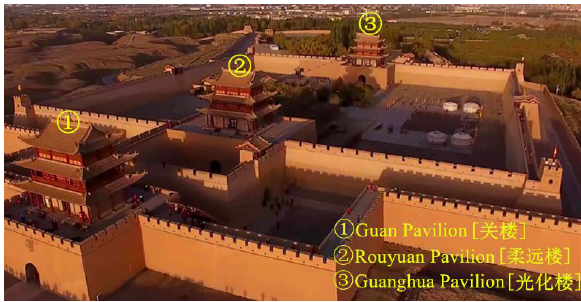
Figure 1. An aerial view of Jiayuguan [ 嘉峪关 ] pavilions